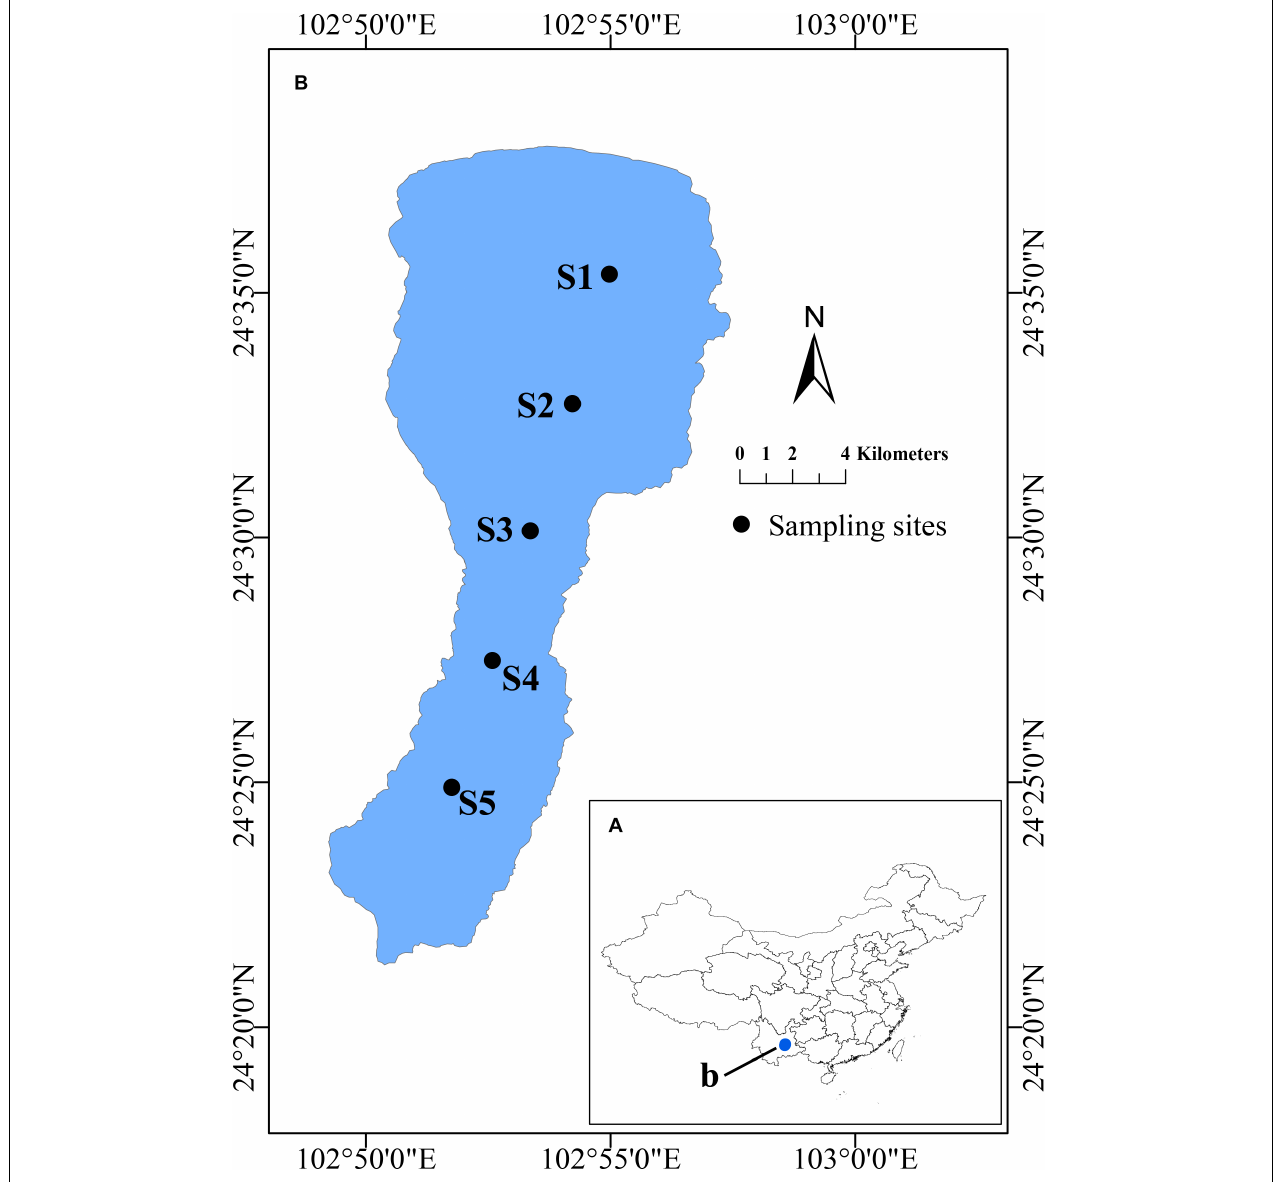
FIGURE 1 | Location of Lake Fuxian in China and the sampling sites. (A) Location of Lake Fuxian in China. (B) Distribution of the sampling sites in Lake